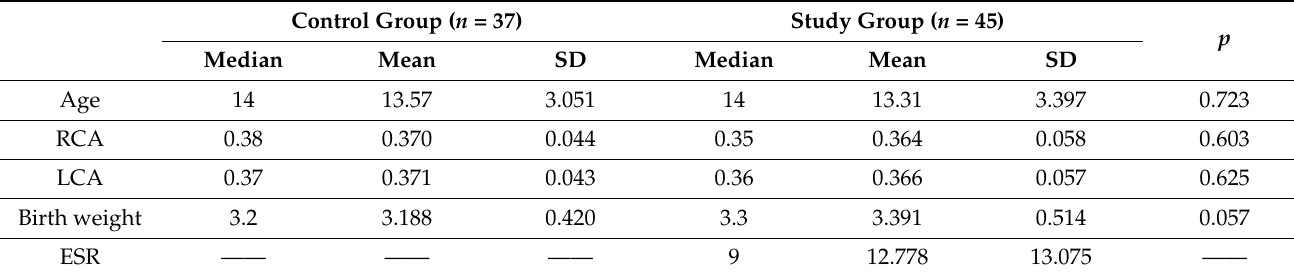
Table 2. Characteristics by group